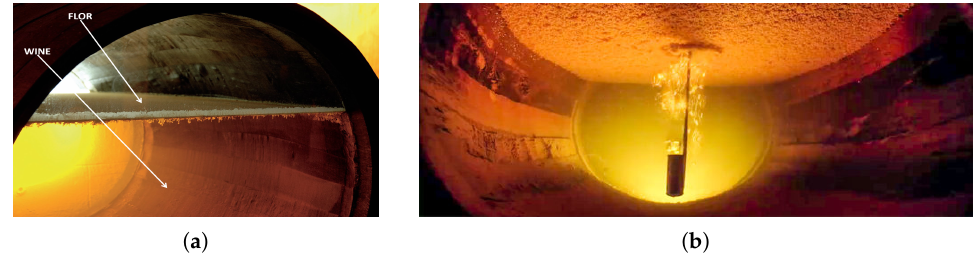
Figure 1. Flor yeast layer. ( a ) Internal view of a Fino wine cask; ( b ) the view of a film of yeasts from the bottom.